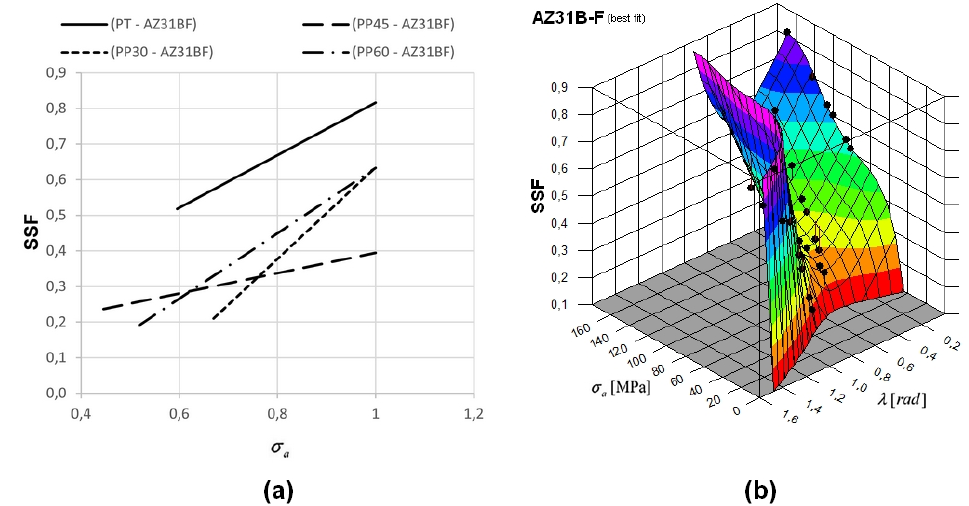
Figure 6. ssf variation for the AZ31B-F magnesium alloy. ( a ) ssf trend lines based on experimental data, ( b ) Tridimensional graph of Equation (2) representing the ssf variation according to the normal stress amplitude and stress amplitude ratios–ssf damage map.